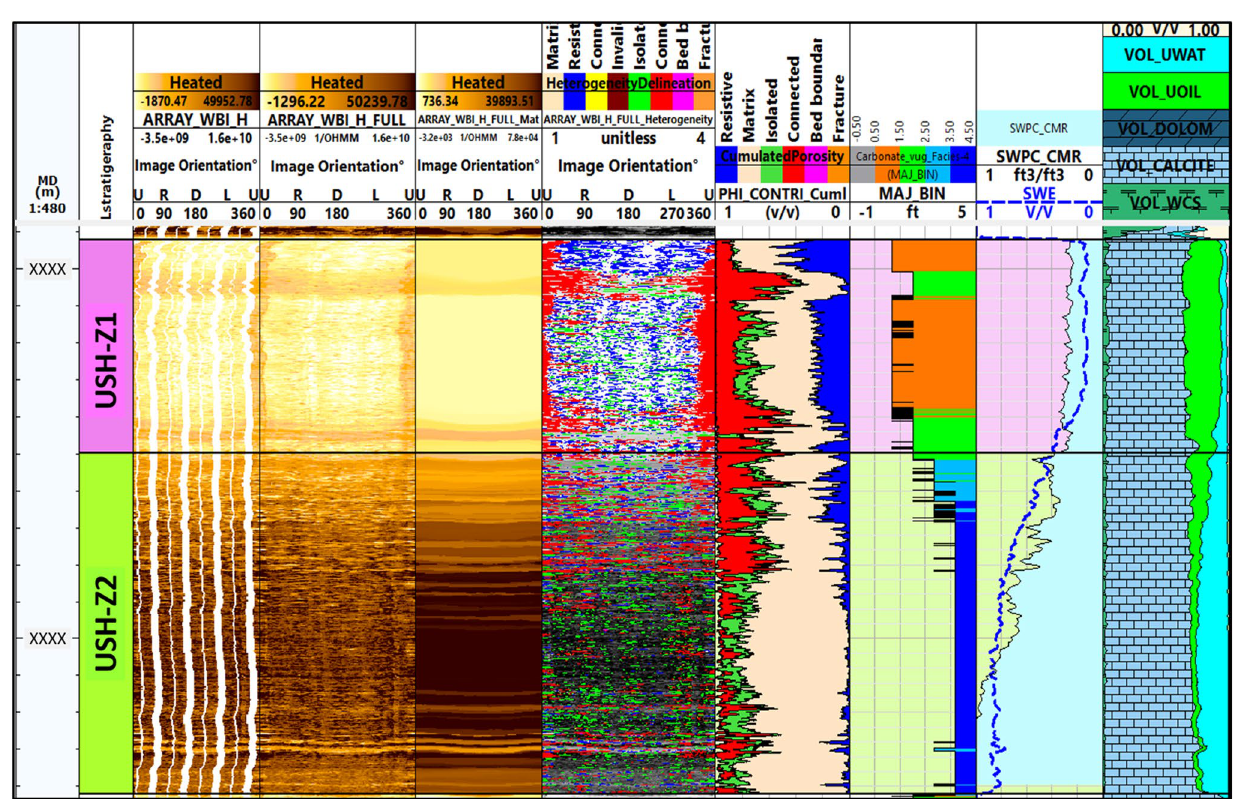
Fig. 18 comparison between porosity distribution from BHI (Track 7) and facies from BHI (Track